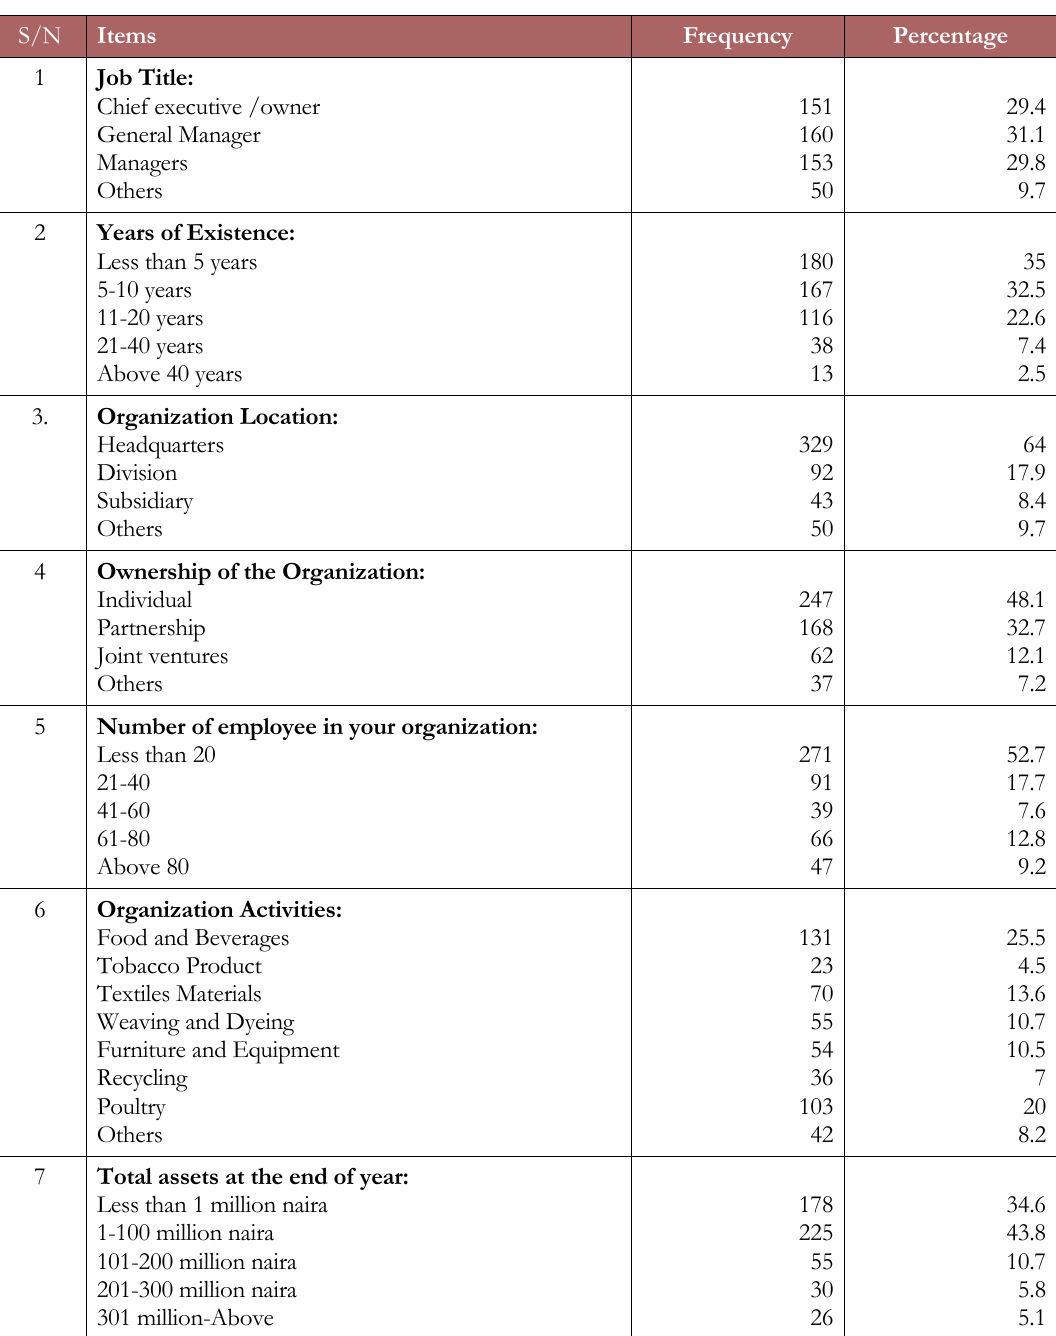
Table 1. Summary of respondents